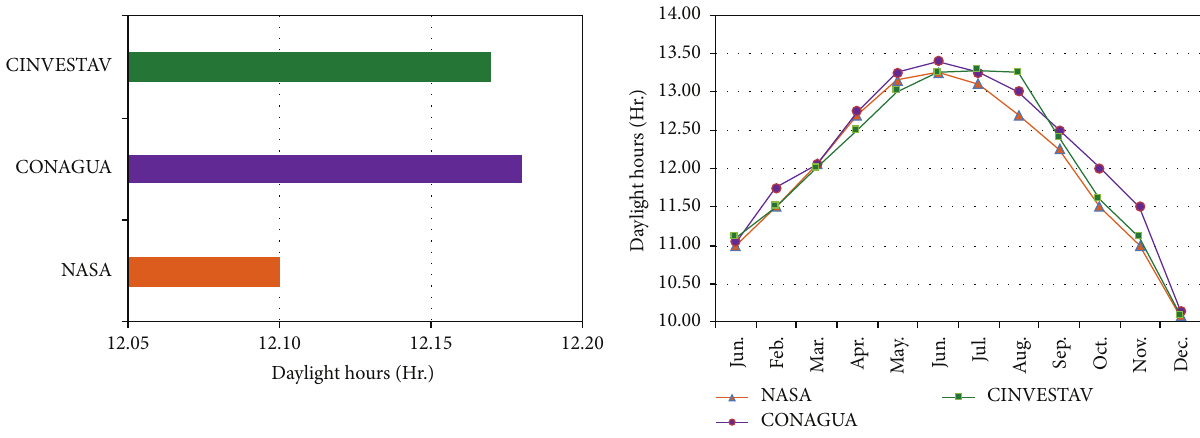
Figure 4: Daylight hours annual and monthly daily mean.